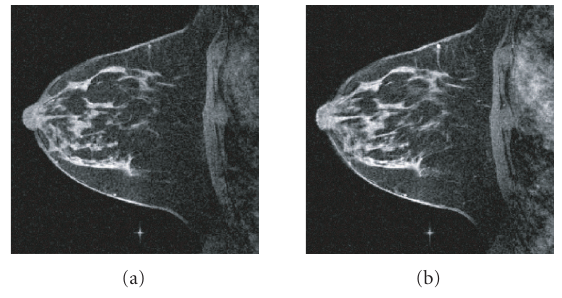
Figure 4: A pair of MR breast images: (a) precontrast image, and (b) postcontrast image.